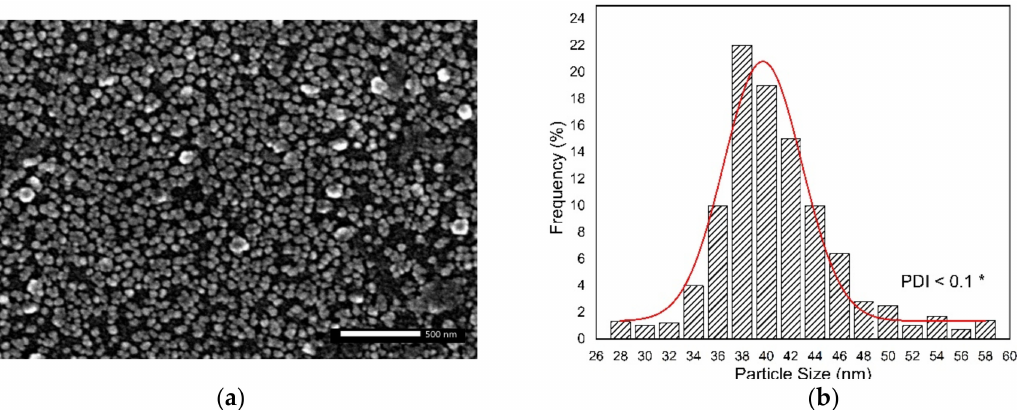
Figure 1. ( a ) SEM image of ChNPs indicates grains of particles without agglomeration, and ( b ) histogram of particle sizes distribution shows average size of ChNPs to be 39.68 nm. * Polydispersity Index